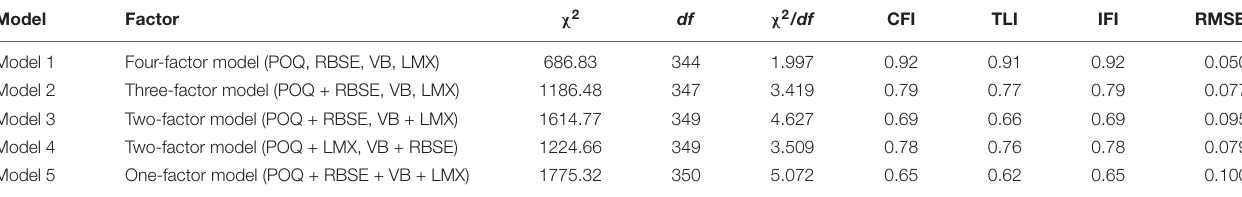
TABLE 1 | Confirmatory factor analysis.